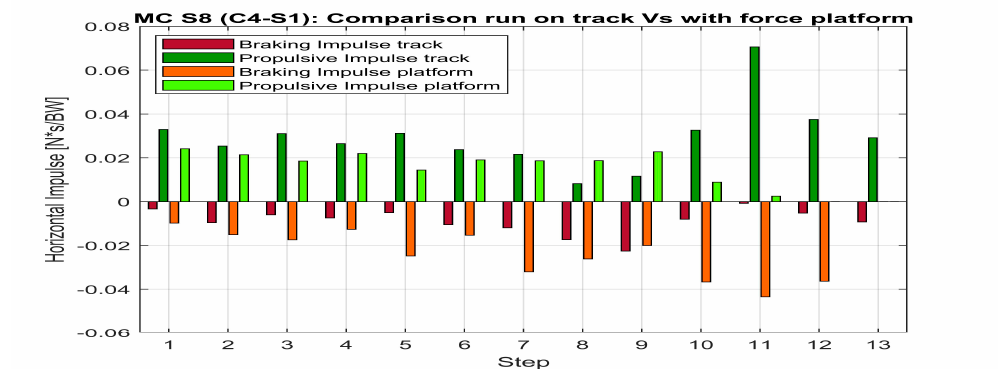
Figure 7. Comparison of the Horizontal Impulse from the affected limb calculated with the iRPF during a sprint aiming to the force platform (step 8) and a free sprint: All steps of a free sprint test on track (Run 12, “Track”) in dark colors, all steps of a test aiming to a Force platform (Run 10 “Platform”) in